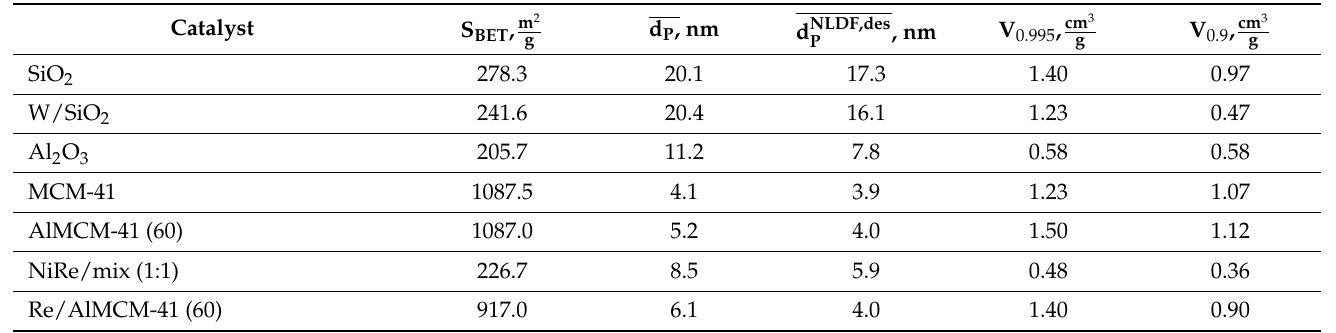
Table 2. N 2 -physisorption data for the applied support and catalyst materials as fresh and tested systems after reaction under the specific metathesis reaction